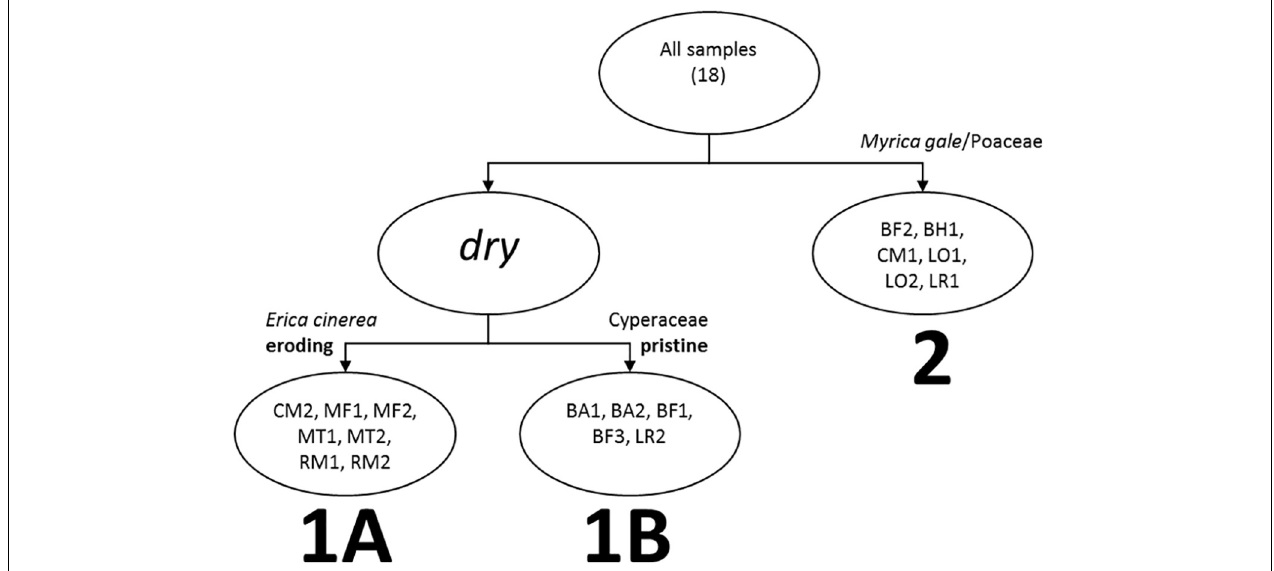
FIGURE 3 | Visual representation of WinTWINS clustering based on % areal cover of vegetation within 10 m radius of the pollen sampling point. Sample locations and codes are shown in Figure 1 .